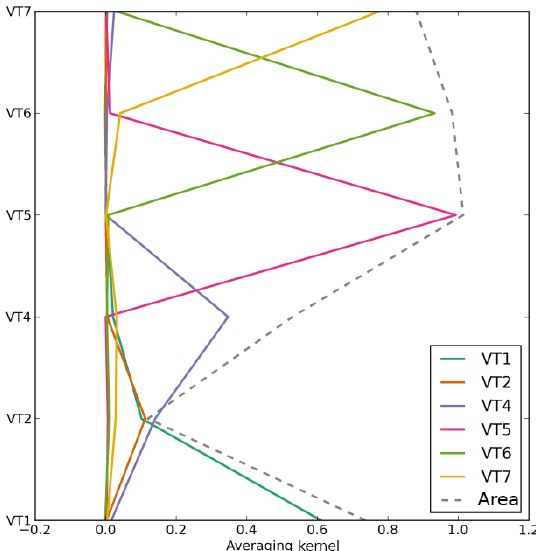
Figure 5. Averaging kernels for the emission factors of the six veg- etation types included in the optimization. The dotted line shows the area under the averaging kernel for each vegetation